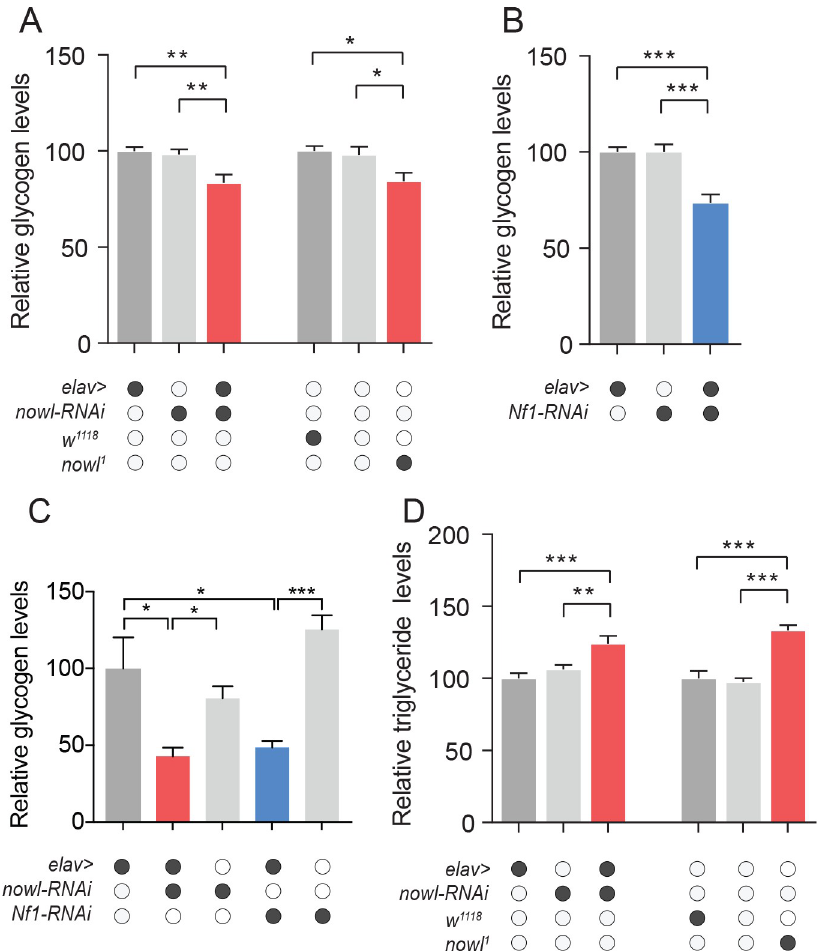
Fig 7. Loss of nowl and Nf1 leads to physiological changes that affect energy homeostasis. (A-C) Quantification of whole-body glycogen (A, B) and triglyceride (D) content, and head glycogen (C), in adult male flies. Neuronal knockdown of nowl ( elav > nowl-RNAi ) or Nf1 ( elav > Nf1-RNAi ) or mutation disrupting nowl ( nowl 1 /Y ) results in reduced whole-body glycogen levels (A, B) compared to controls ( elav > + , nowl-RNAi/+ , Nf1-RNAi/+ , w 1118 /Y , and +/Y ). (C) Effect of neuronal nowl and Nf1 knockdown on glycogen content of the head. (D) Whole-body lipid content is increased in animals with neuronal knockdown of nowl or a mutation disrupting nowl . Graphs represent means with SEM (n = 5–20) of data from one experiment. Significance was determined using Kruskal-Wallis test with Dunn’s post-hoc testing ( � p < 0.05, �� p < 0.01, ��� p < 0.001).